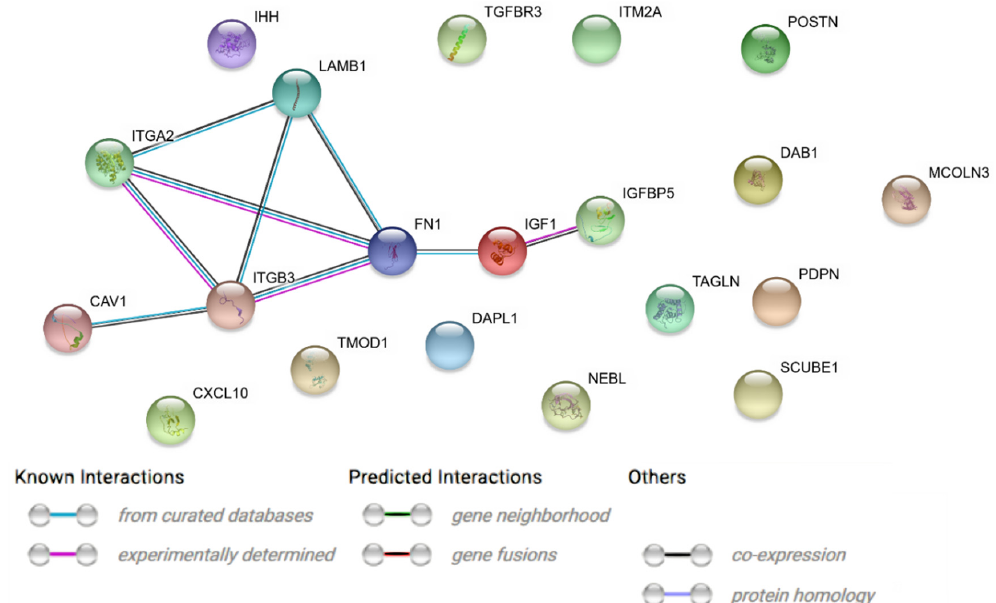
Figure 6. STRING-generated interaction network among the between 10 most upregulated and 10 most downregulated genes that belongs to “cell development”, “cell differentiation” and “cell morphogenesis” GO BP terms. The intensity of the edges reflects the strength of interaction score.